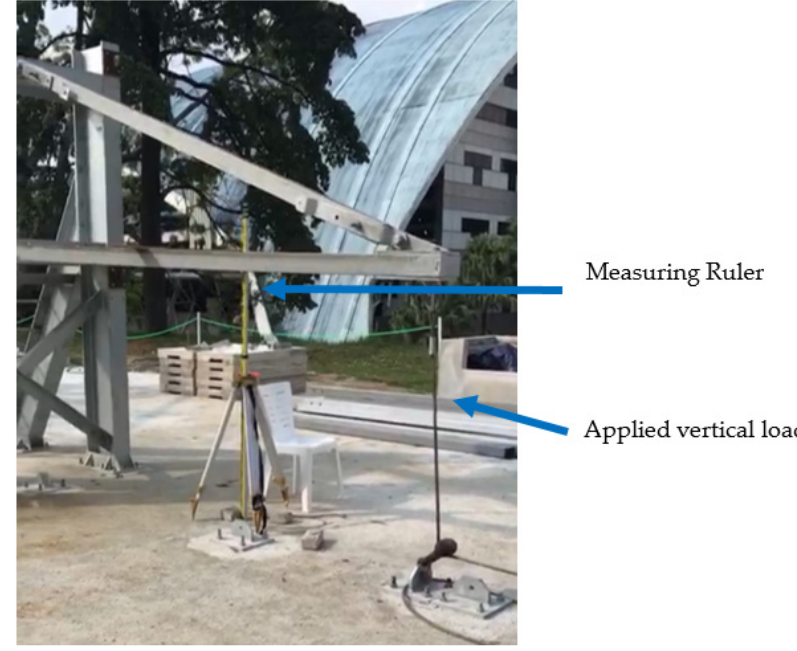
Figure 4. Full Assembly testing of GFRP cross ‐ arm subjected to vertical load.